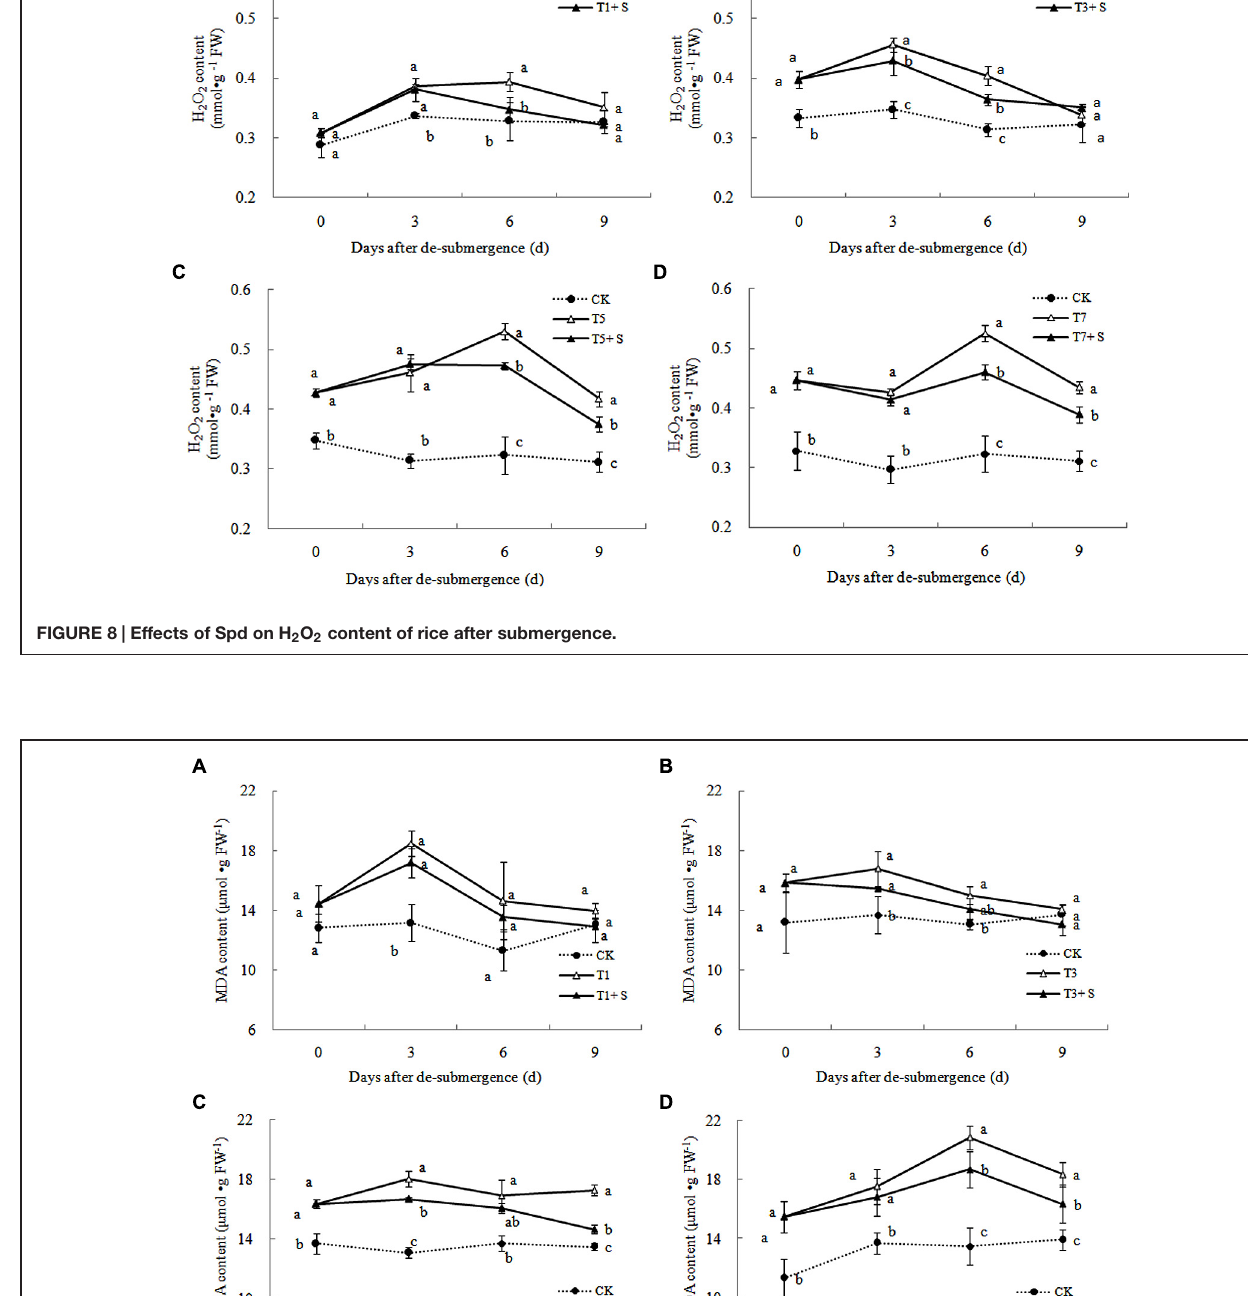
Frontiers in Plant Science |